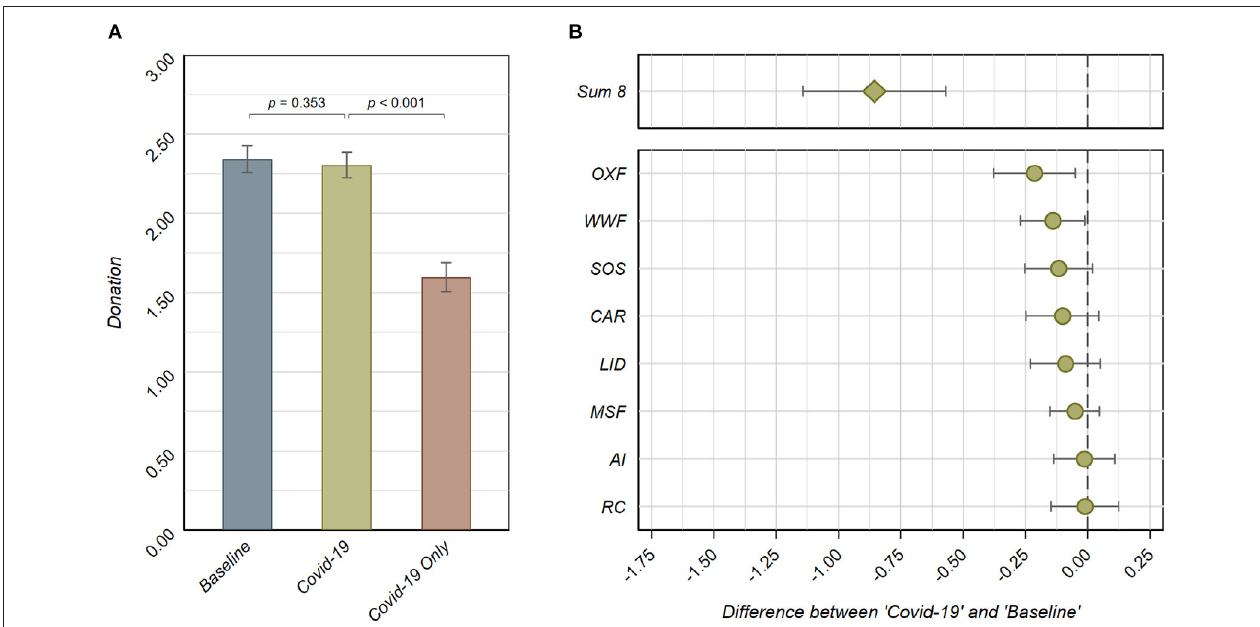
FIGURE 1 | (A) avg. total donations (pooled across charities) per treatment in e . p -values are based on Tobit regressions with e 0 and e 3 as the lower and upper limit, respectively (endowment e 3), and robust standard errors. (B) Point estimates and 95% confidence intervals of the differences in avg. sum-8 donations between the Baseline and the COVID-19 treatment, based on Tobit regressions of the amount donated to the respective charitable organization on a treatment indicator for the COVID-19 treatment (with e 0 and e 3 as the lower and upper limit, respectively, and robust standard errors). Negative values represent lower donations in the COVID-19 treatment than the Baseline treatment. All pairwise comparisons between coefficients based on Wald tests after seemingly unrelated regressions (with robust standard errors) are insignificant, except for OXF – AI ( χ 2 (1) = 3.949, p = 0.047). The estimate at the top indicates the difference in the sum of donations to the eight charitable organizations between the Baseline and the COVID-19 treatment ( t (1178) = 5.851, p < 0.001; n = 1,180).